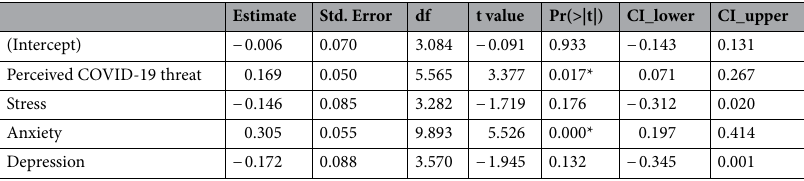
Table 1. Model 1 estimates (DV: Everyday altruism, SRA).